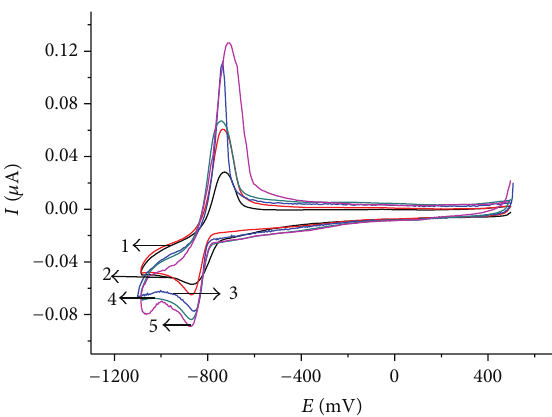
Figure 7: Cyclic polarization curves on the glassy carbon electrode at different temperatures in the absence of oxygen. Conditions as given in Figure 4. (1) 25 ∘ C, (2) 35 ∘ C, (3) 45 ∘ C, (4) 55 ∘ C, and (5) 65 ∘ C.